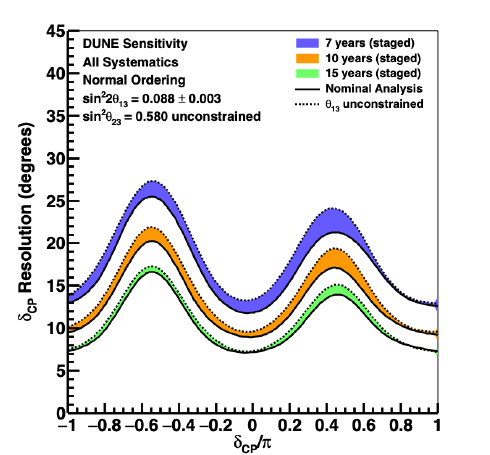
Figure 11. Resolution in degrees for the DUNE measurement of δ CP , as a function of the true value of δ CP , for seven (blue), ten (orange), and fifteen (green) years of exposure. The width of the band shows the impact of applying an external constraint on θ 13